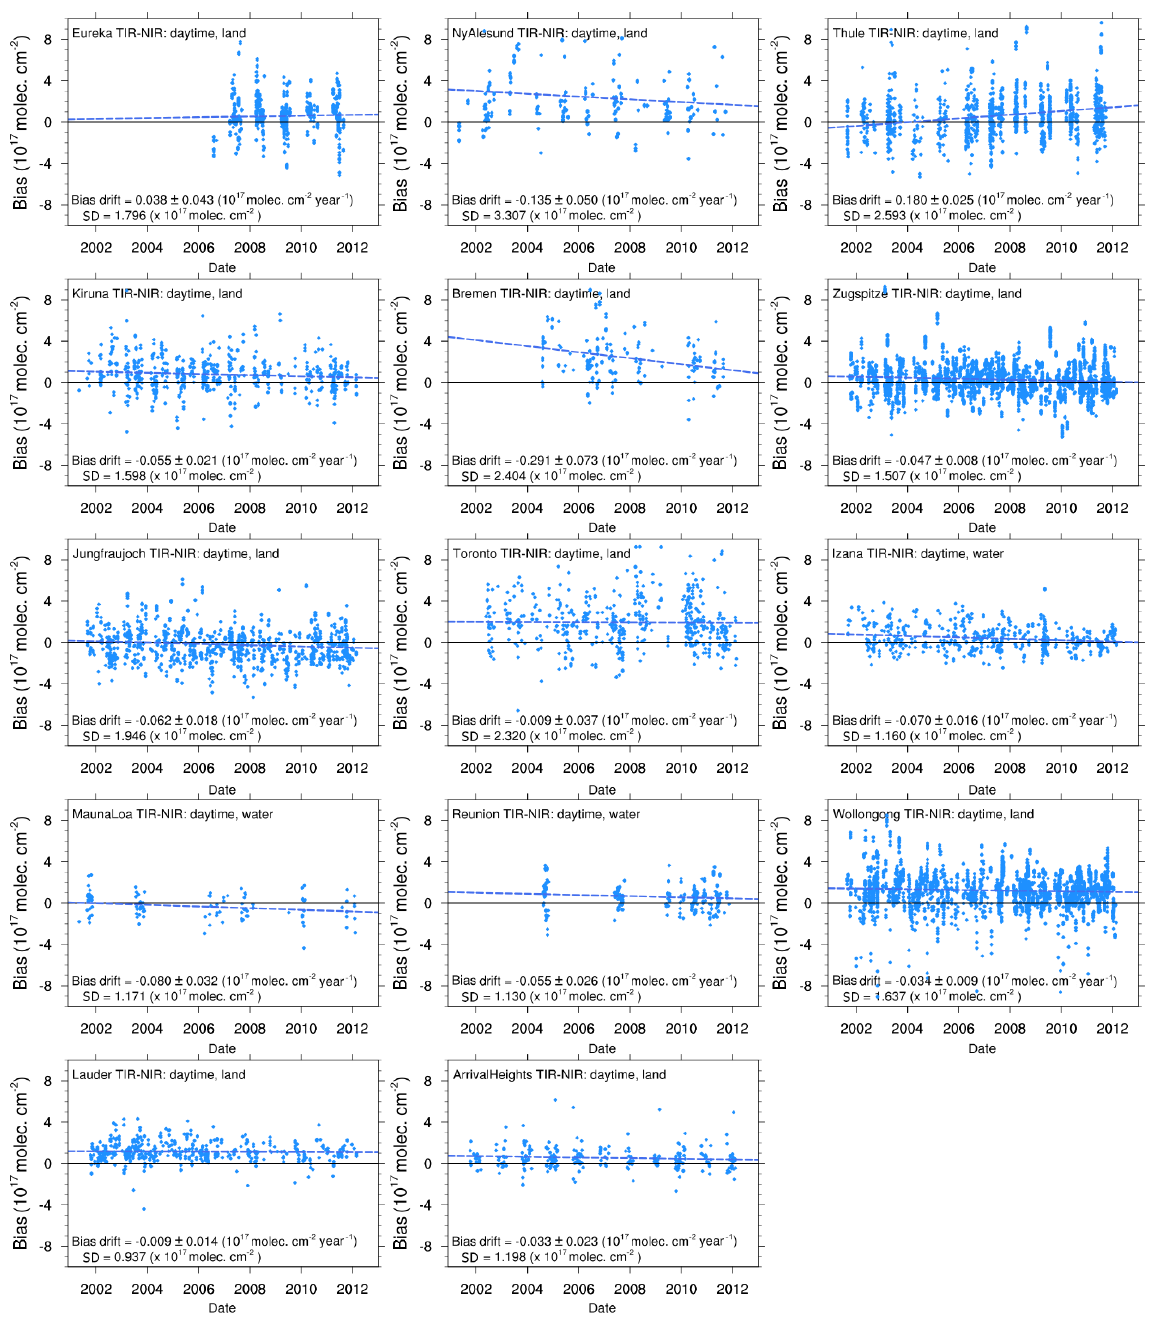
Figure 8. Temporal evolution of bias (MOPITT–FTS) at all stations for V6 joint TIR–NIR product. The blue dashed line indicates bias drift calculated from a linear least squares regression. Plots are ordered by latitude, from north to